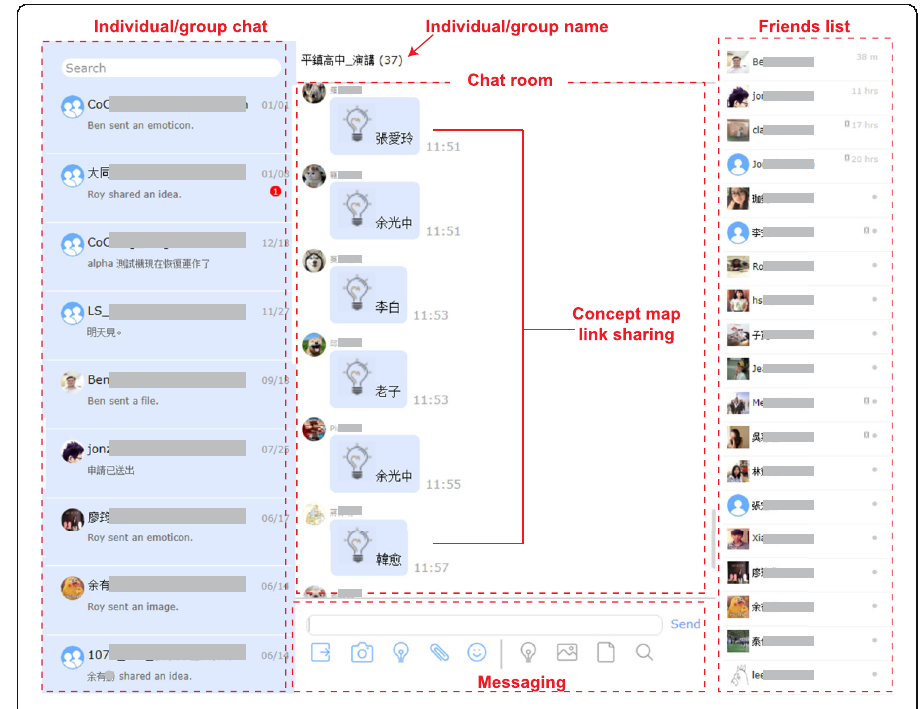
Fig. 4 Instant message sharing tool